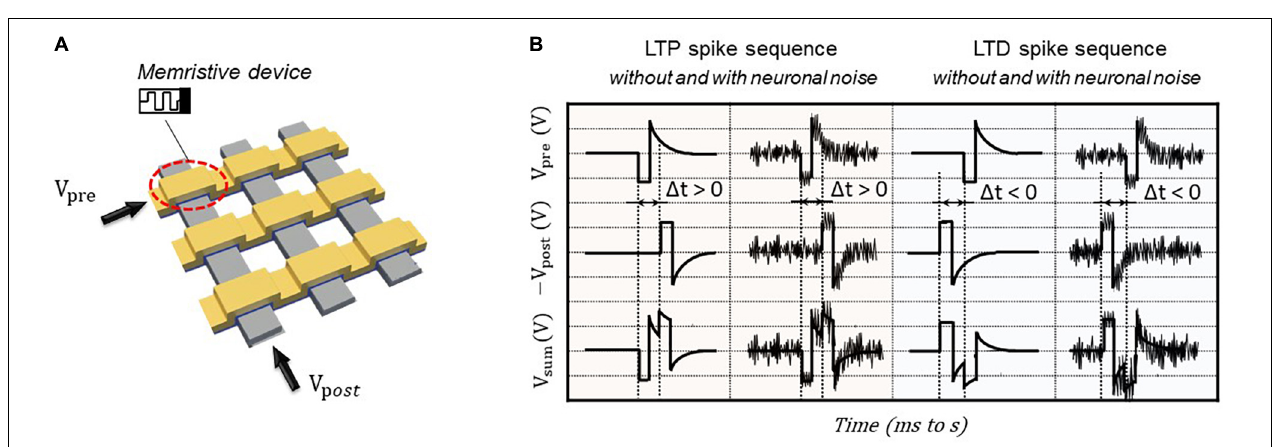
FIGURE 2 | Illustrative schemes for memristive artificial synapse and STDP driving voltage waveforms. (A) Circuit demonstration for STDP implementation by applying pre- and postsynaptic voltages to TEs and BEs to one memristive artificial synapse in crossbar array, respectively. (B) Quasi-static stimulation protocol applied to TE of BFO memristive artificial synapse for emulating LTP and LTD learning rules without and with neuronal